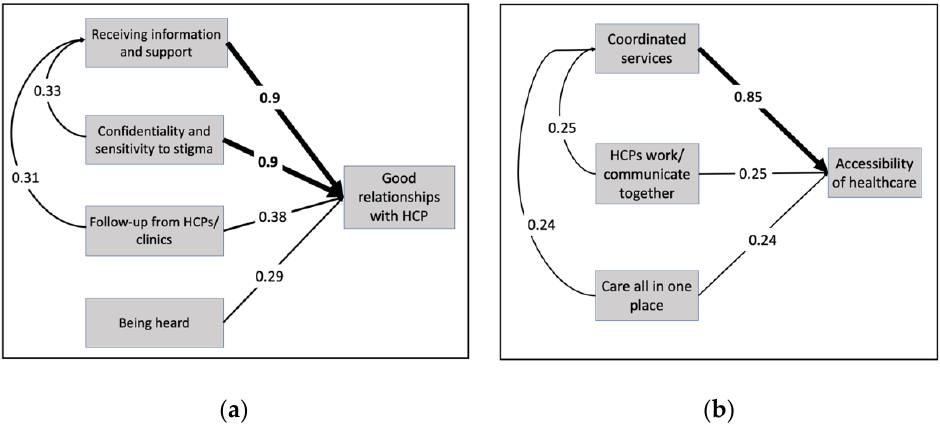
Figure 4. Self-pointing arrows in the final map at the factor level. The strongest internal dynamics between factors within the categories ( a ) feeling safe and supported and ( b ) accessible and coordinated services. Weights closer to 1 indicate higher influences. The highest weighted influences are bolded.